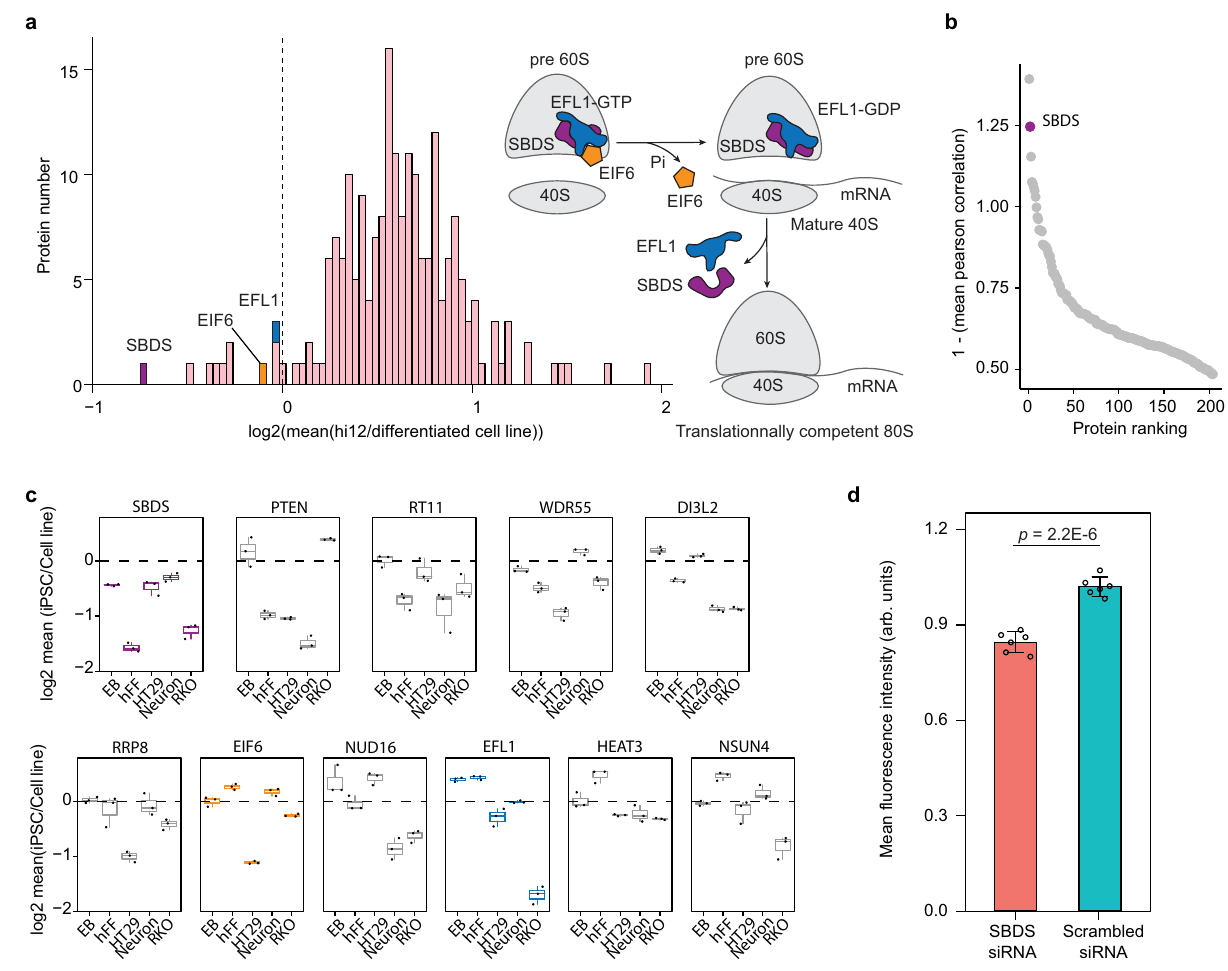
Fig. 5 SBDS controls protein synthesis rate in iPSCs. a Expression of proteins involved in ribosome biogenesis in hi12 iPSCs compared to that in parental hFFs, EBs, and neuronal cells differentiated from hi12 iPSCs, HT29, and RKO cells ( n = 3 biologically independent samples). b Ranking of all ribosome biogenesis factors according to the reversed mean correlation of their expression against each other individual ribosome biogenesis factors ’ expression in all the cell lines mentioned above. c Expression of the ten most downregulated ribosome biogenesis factors in each cell line compared to that in hi12 iPSC. Boxplots of SBDS, EIF6, and EFL1 proteins are colored in purple, orange, and blue, respectively, while other proteins are colored in gray ( n = 3 biologically independent samples). Horizonal line in the boxplots represent the median, 25th and 75th percentiles and whiskers represent measurements to the 5th and 95th percentiles. d OPPuro incorporation measurement in SBDS siRNA and scrambled siRNA (control) treated hFFs 3 days after the treatment, data were normalized to the mean fl uorescence intensity in the scrambled siRNA control ( n = 6 biologically independent samples). Error bars represent ±the standard deviation of the mean. P -values were calculated using a two-sided Student t -test. p < 0.05 were considered as signi fi cant. Source data are provided as a Source Data fi